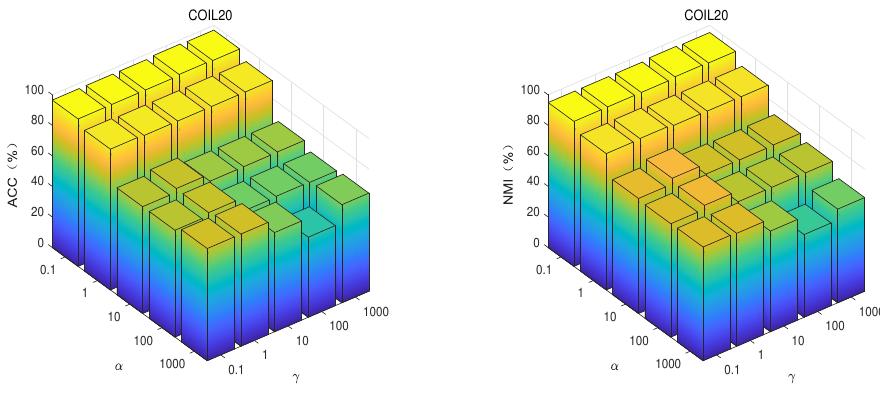
Figure 3. With fixed λ = 100 and γ = 1, ACC and NMI of GSNMF-EMD with different α and β and the same number of clusters on the COIL20 dataset.